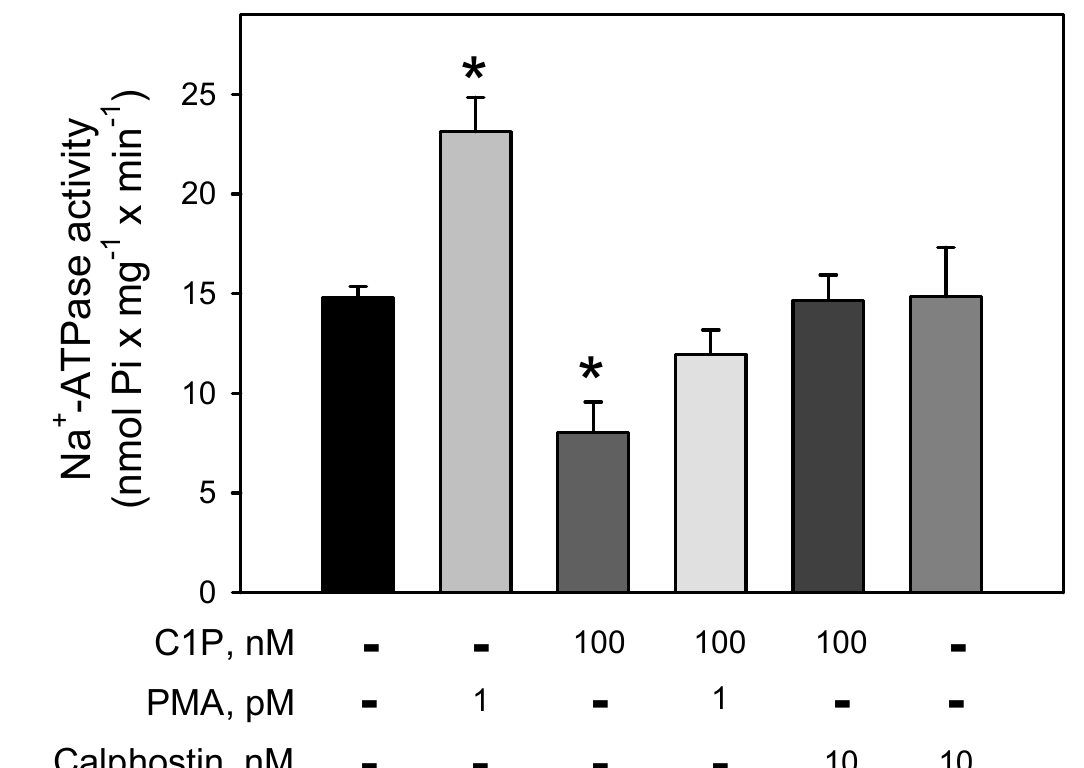
Figure 3. C1P inhibition of the Na + -ATPase activity is completely abolished by pre-incubation of the BLM with calphostin, a specific PKC inhibitor. Na + -ATPase activity was assayed in the presence of 100 nM C1P, phorbol myristate acetate (PMA) 1 pM, and calphostin C 10 nM alone or in the different combinations shown on the abscissa. Data are expressed as means ± SE of at least six experiments conducted in triplicate using BLM fractions from different kidney preparations. * Statistical difference related to the control ( p < 0.01).